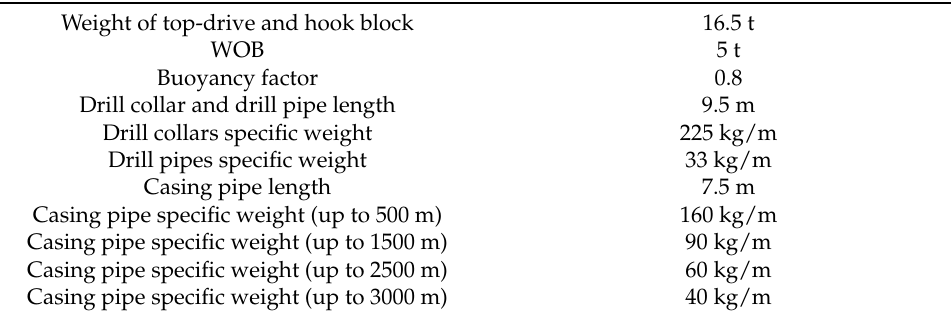
Table 2. Constructive parameters of the drill